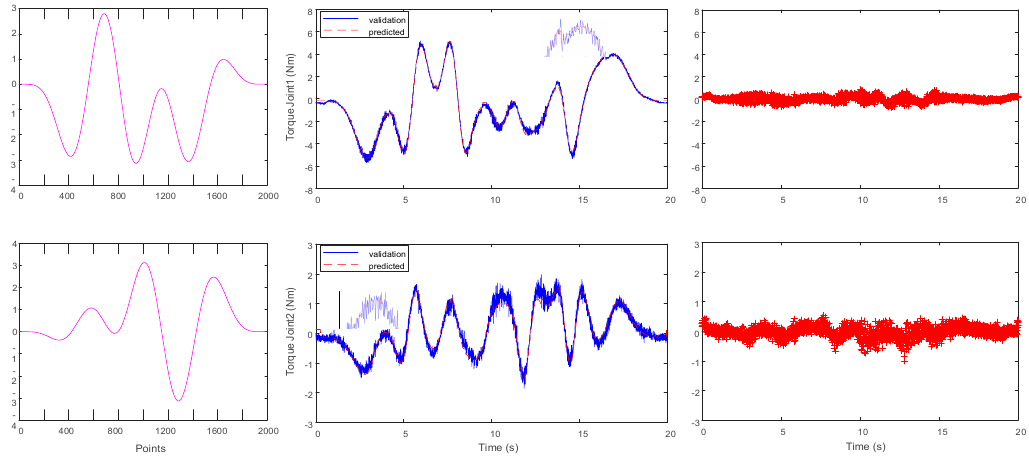
Figure 8. Measured position and torque and predicted and residual torques of the validation experiment. Table 6. Root mean square (RMS) of the measured and predicted residuals (Nm). Joints